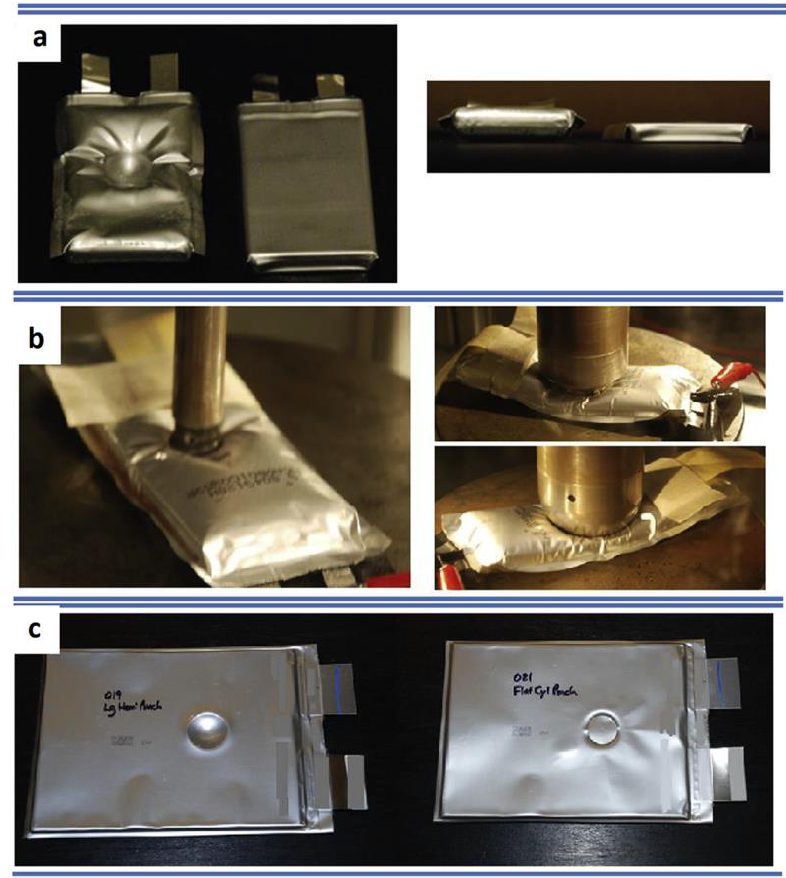
Figure 11. ( a ) Inflation of small pouch cell due to hemispherical punch indentation, ( b ) Inflation of medium pouch cell due to hemispherical punch indentation, ( c ) Inflation of large pouch cell due to hemispherical and cylindrical punch indentations. Reproduced with permission from ref. [139]. Copyright 2013. Elsevier B.V.